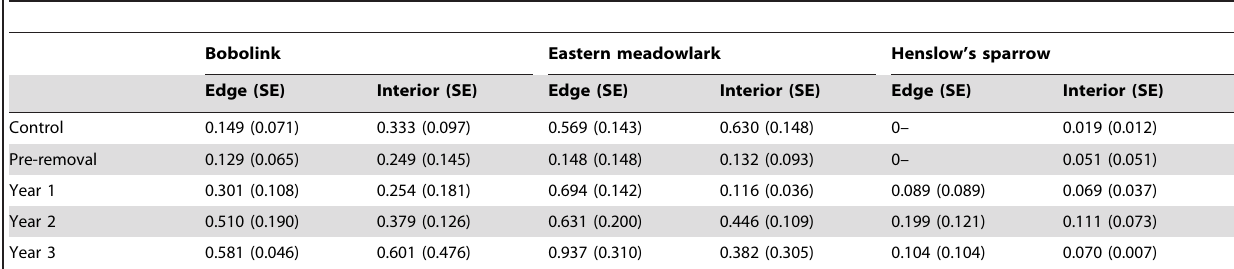
Table 2. Mean apparent nest density (number/ha) and standard errors (in parentheses) for obligate grassland birds in tree row edge and grassland interior habitats on the control and removal sites.